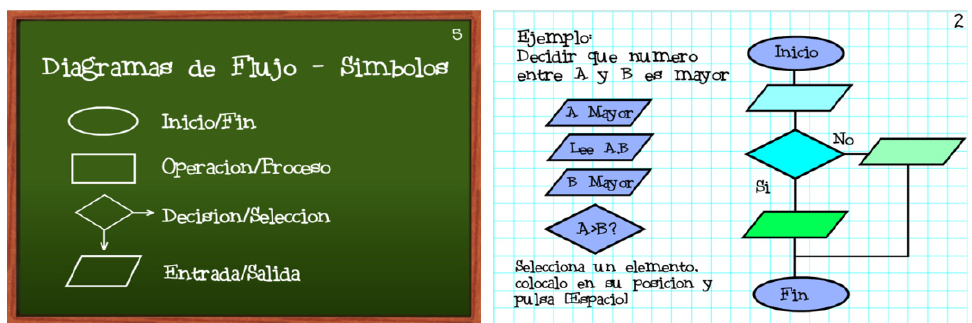
Figure 2. Examples of exposure ( left ) and practice ( right ) in the TPACK Guided Scratch VEE.